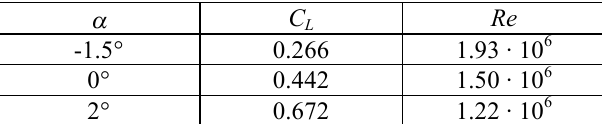
Table. Flow conditions at different angles of attack